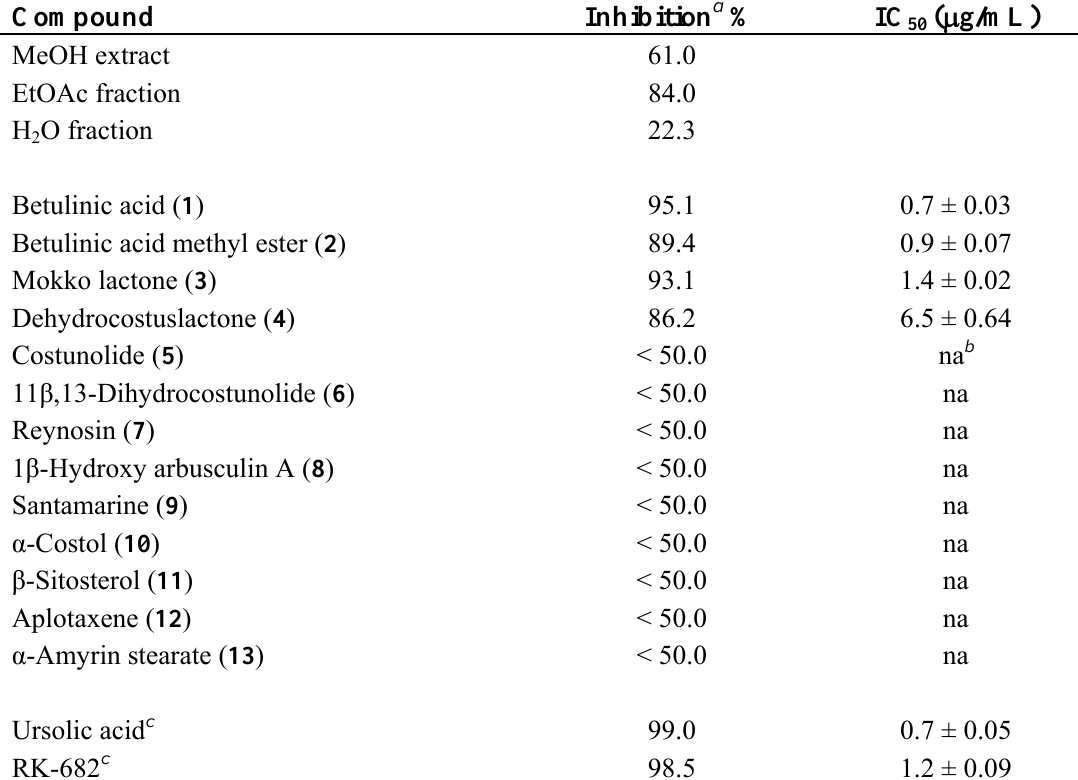
Table 1. PTP1B inhibitory activity of compounds 1 – 13 isolated from the roots of S.